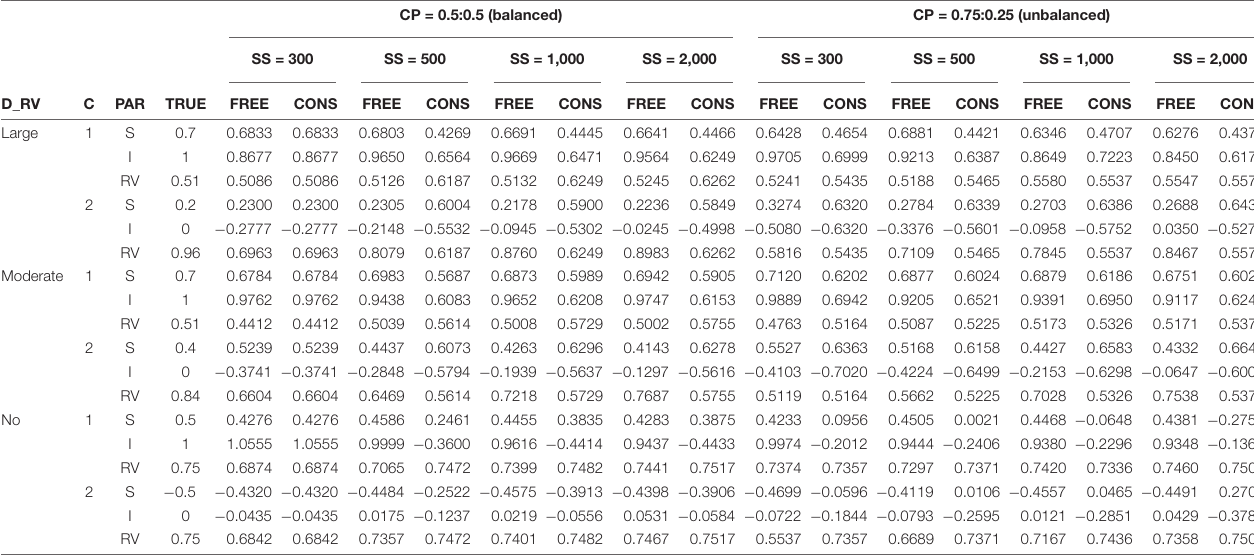
FREE, residual variances freely estimated; CONS, residual variances equally constrained; SS, sample size; CP, class proportion; D_RV, the disparity in the magnitude of class-specific residual variances; C, latent class; TRUE, population values for each parameter; PAR, parameters; S, class-specific slope; I, class-specific intercept; RV, class-specific residual